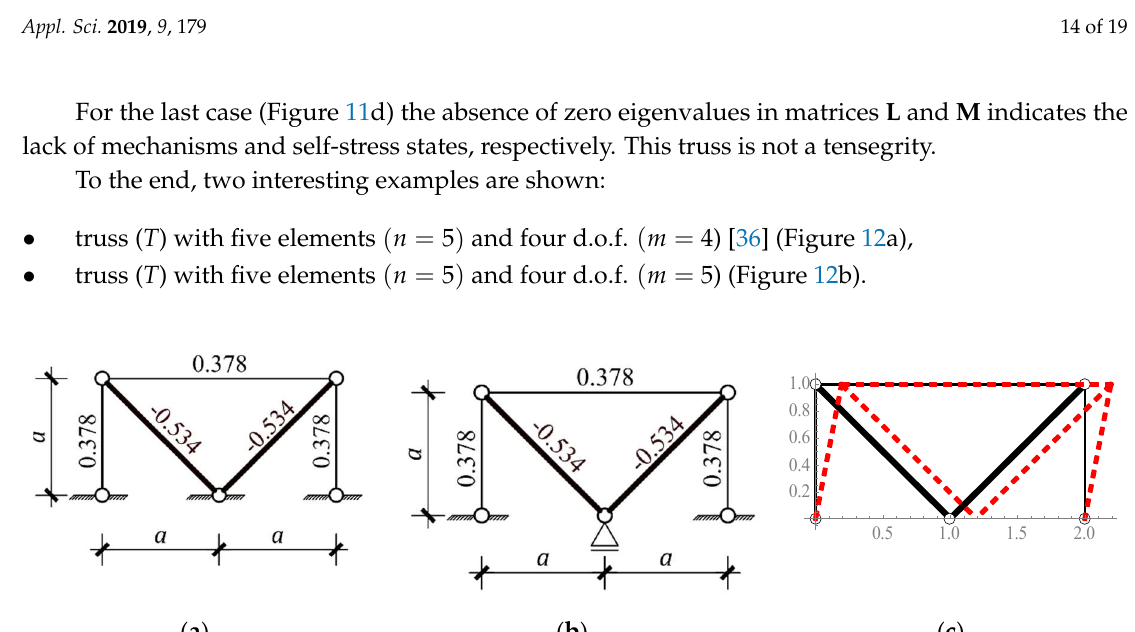
shown in ( b shown in ( b ).